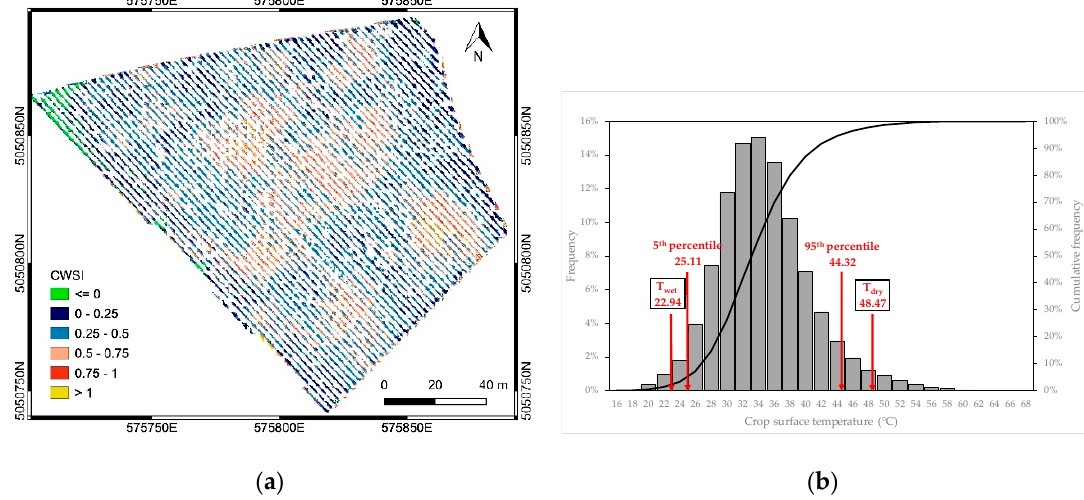
Figure 10. CWSI map after soil masking ( a ), derived considering the T wet and T dry values calculated as the mean of the coolest 5% and the hottest 5% vegetated pixels in the crop surface TIR orthomosaic, respectively. The frequency distribution of the crop surface temperatures is also reported ( b ).